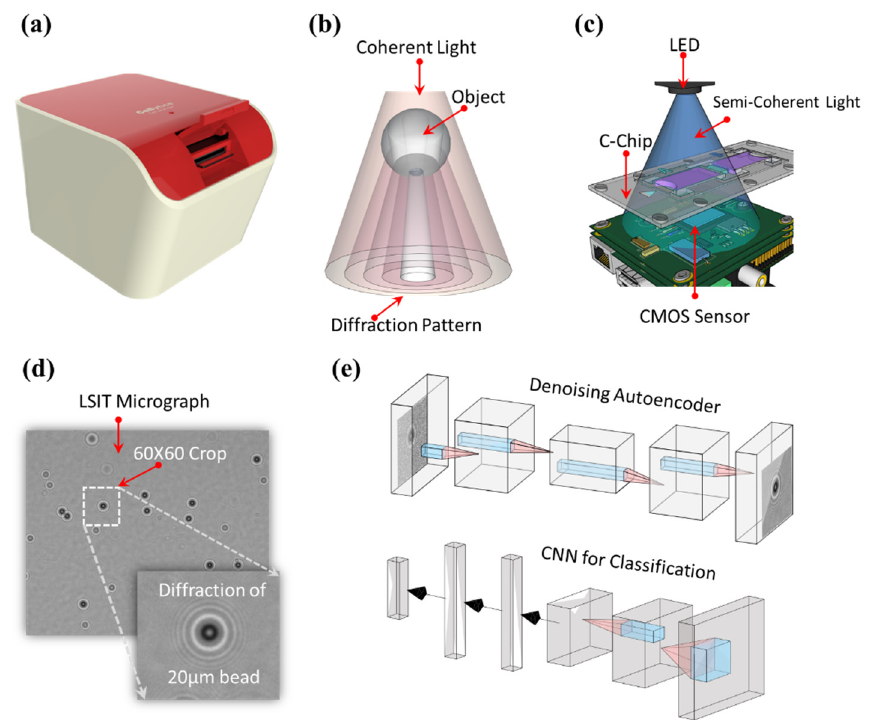
Figure 1. Schematics of the LIST setup and the proposed neural network architecture for the auto characterization of LSIT micrographs. ( a ) LSIT platform (Cellytics) ( b ) schematic of the principle of diffraction, i.e., shadow, pattern generation of a micro-object, ( c ) schematic of the LSIT imaging setup showing the simplicity of the setup, ( d ) schematic of the dataset creation process by automatic cropping individual cell diffraction pattern from the whole LSIT micrograph, and ( e ) the schematic of the proposed denoising and classification architecture. Here, the denoising autoencoder enhances the signal of the individual cells which is then fed to the CNN module for classification.